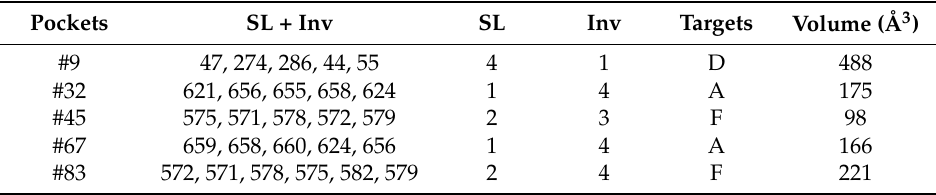
Table 2. Binding site candidates of H1N1 HA.